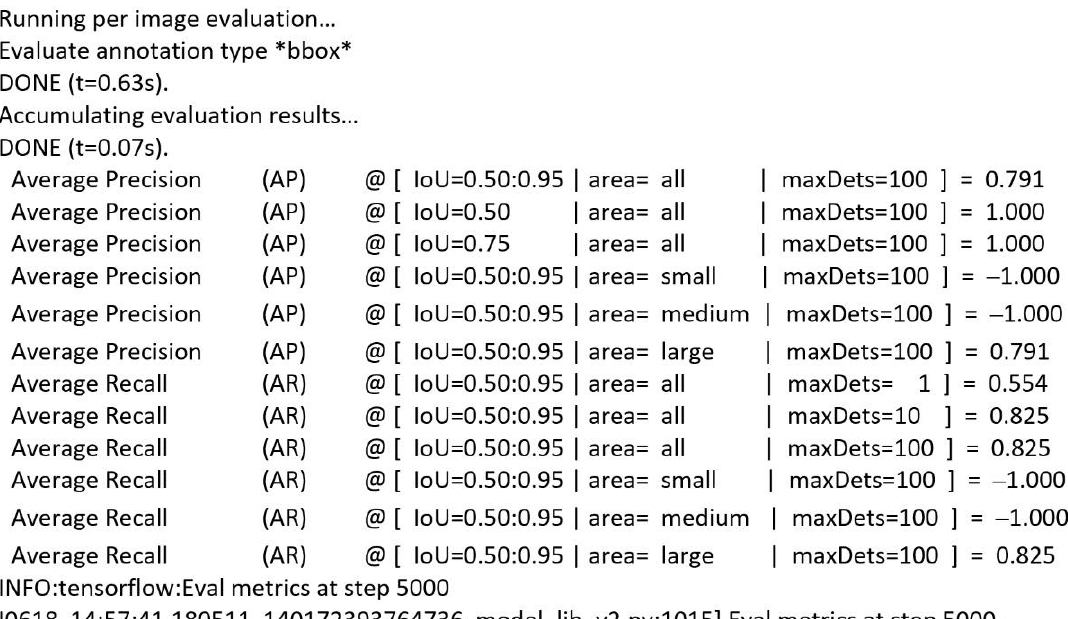
Figure 20. EfficientDet training results.